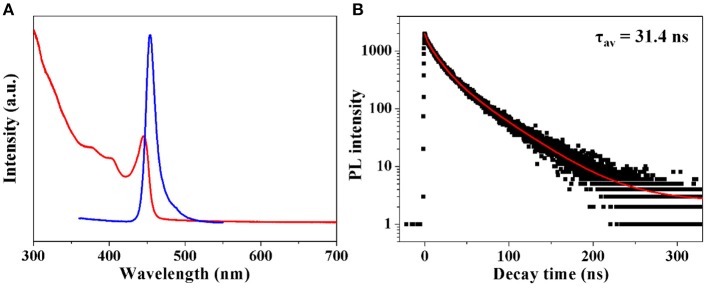
(A) Absorption and PL spectra of as fabricated CH3NH3PbBr3 QDs. (B) Time-resolved PL spectrum of CH3NH3PbBr3 QDs.